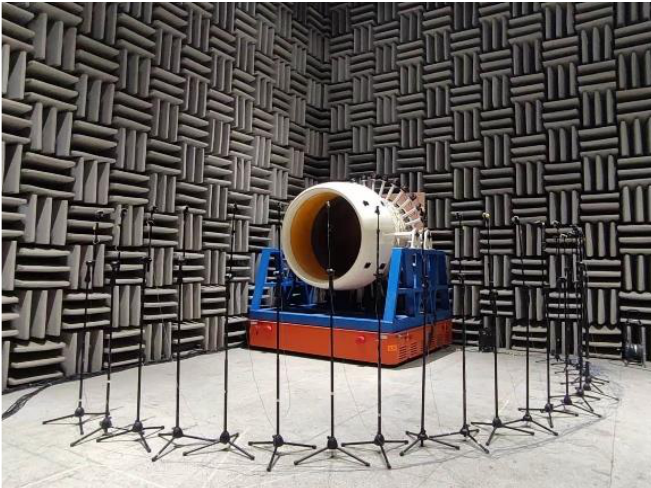
Figure 10. Full size nacelle acoustic liner experimental setup.